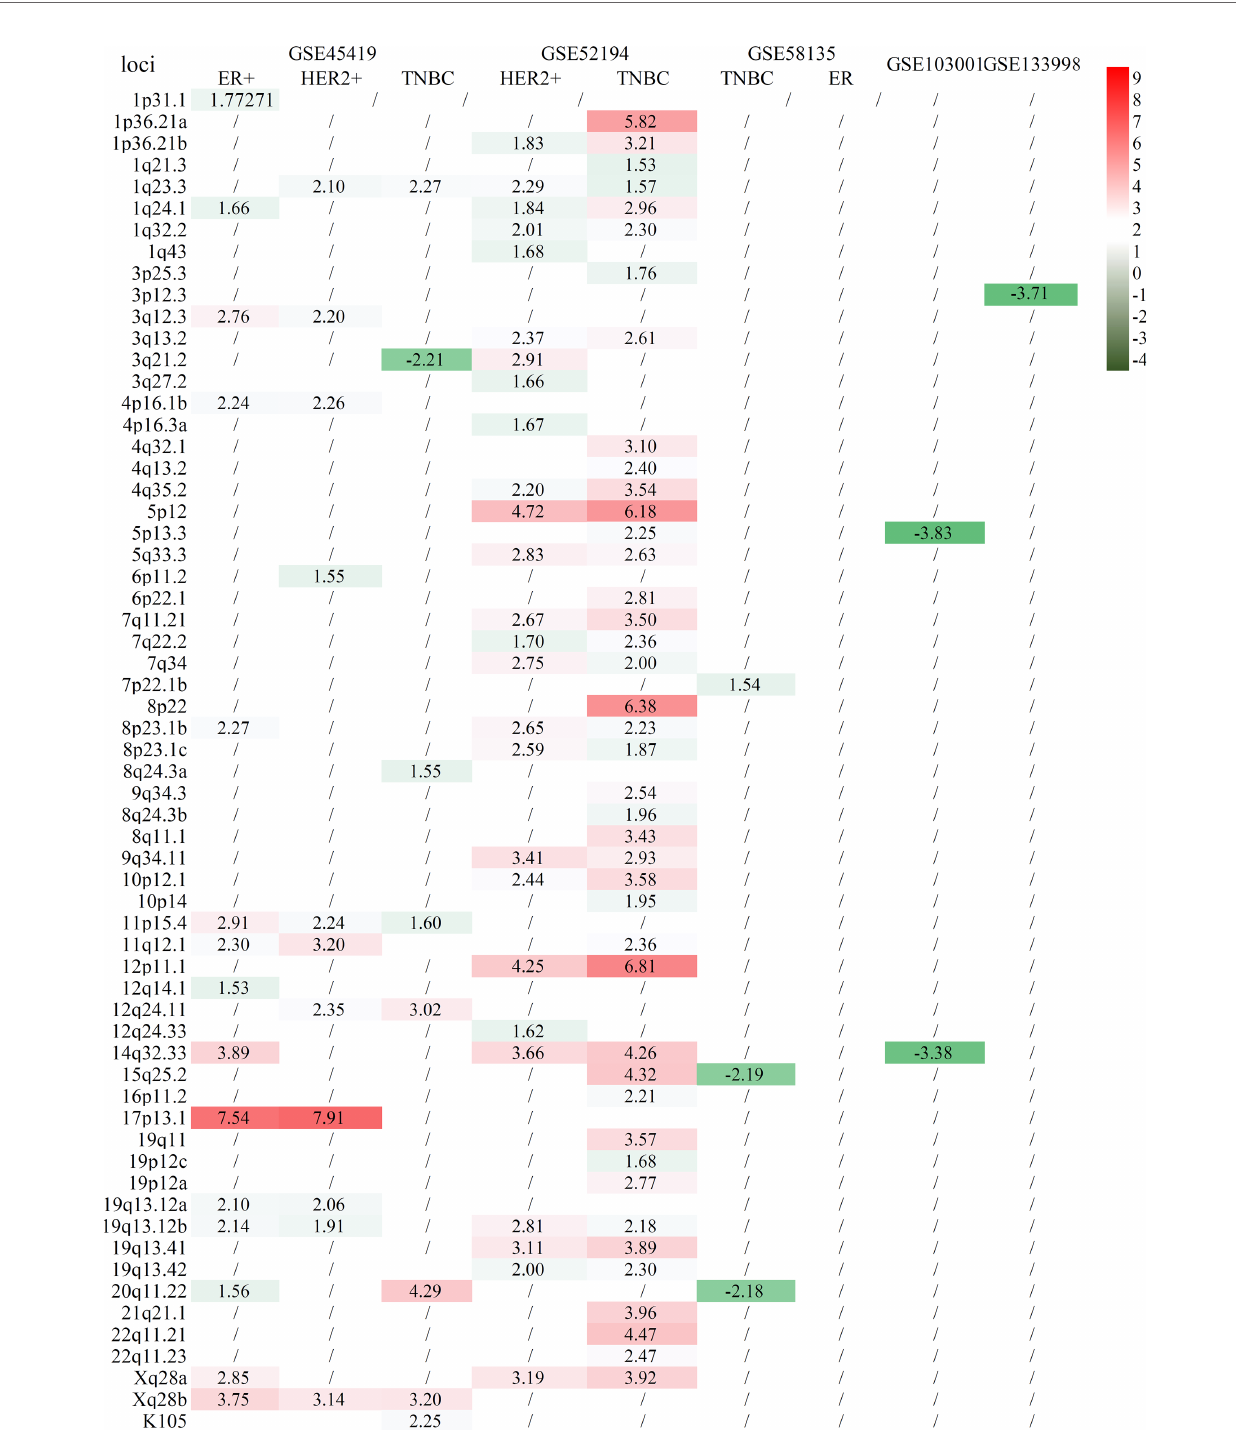
FIGURE 2 | Statistical comparison of several BCa cell lines to normal controls from healthy donors. The row is the loci of HERV-K proviruses, and the column is the comparison of tumor subtypes to normal tissue.